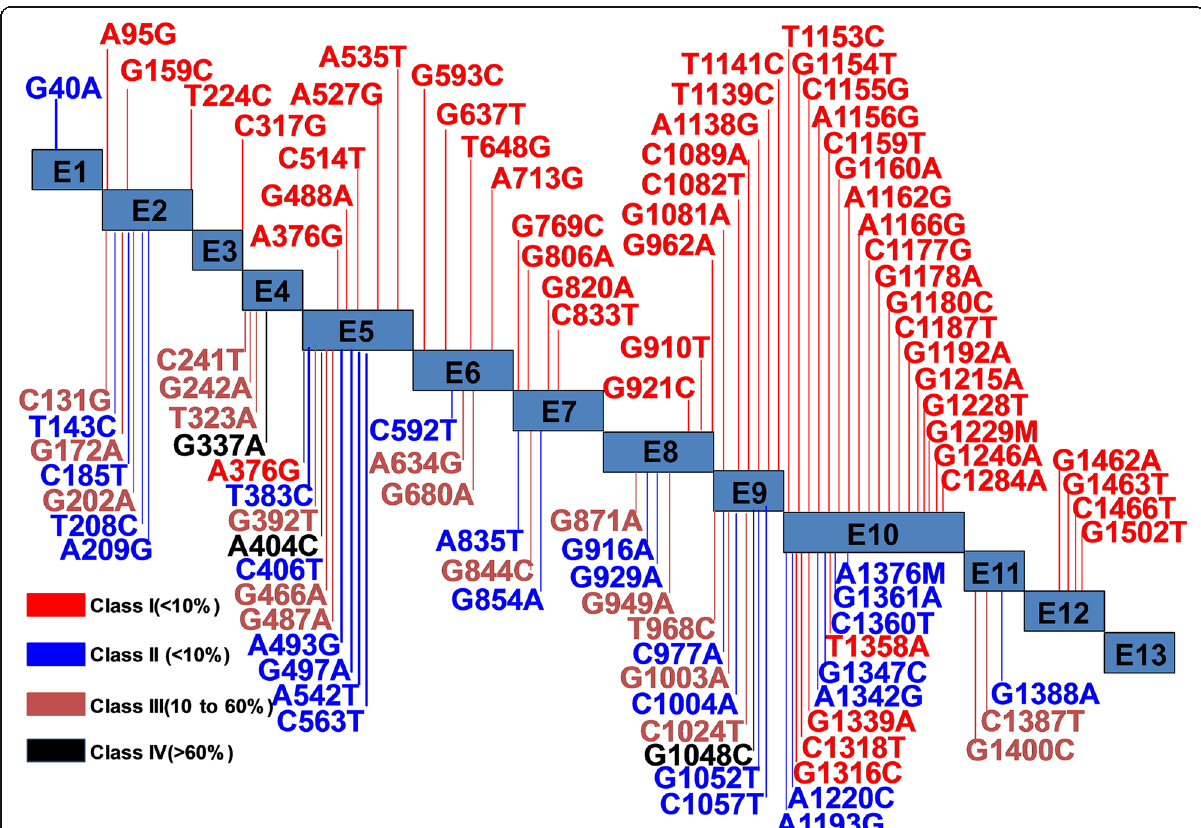
Fig. 1 The common variants and classification in the G6PD gene. The G6PD gene variants are classified into Class I to Class IV based on the genotype and clinical manifestations (WHO classification). Red color indicates a Class I severe enzyme deficiency with chronic non-spherocytic hemolytic anemia (CNSHA). Blue color indicates a Class II severe enzyme deficiency with less than 10% of the normal activity. Orange color indicates a Class III mild to a moderate enzyme deficiency (10 to 60% of normal activity). Black color indicates a Class IV very mild or almost normal enzyme activity (> 60% normal activity and no clinical problem). Data from G6PD gene variant database